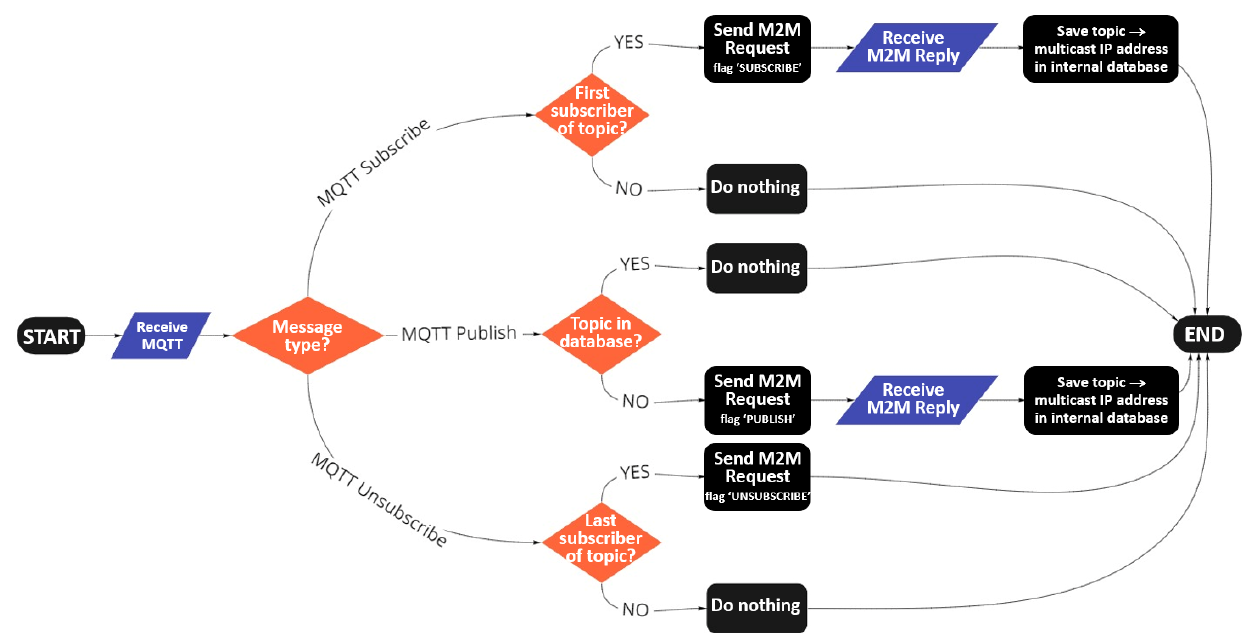
Figure 6. MQTT2MULTICAST flowchart from the MQTT proxy point of view.